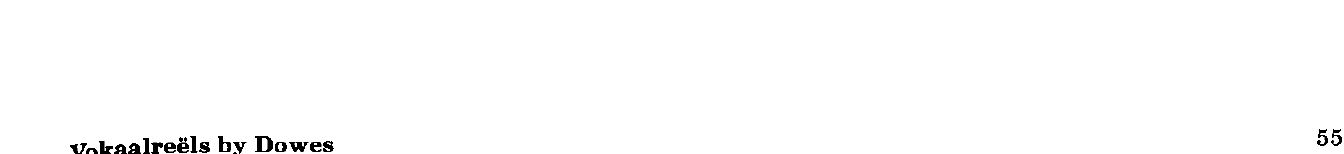
Tabel 8. Vokaalbeoordelings van Spreker Ses